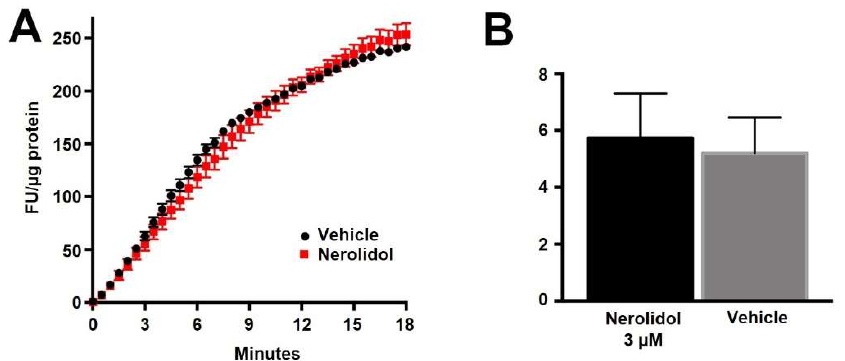
Figure 4. Nerolidol does not alter the basal activity of DAGLα. ( A ) Sample Enzchek lipase activity time course in the presence of vehicle (black) or nerolidol (3 µM, red) in DAGLα-transfected CHO cells. ( B ) Summarized results show lipase activity in DAGLα-expressing CHO cells in response to vehicle or nerolidol ( n = 3).